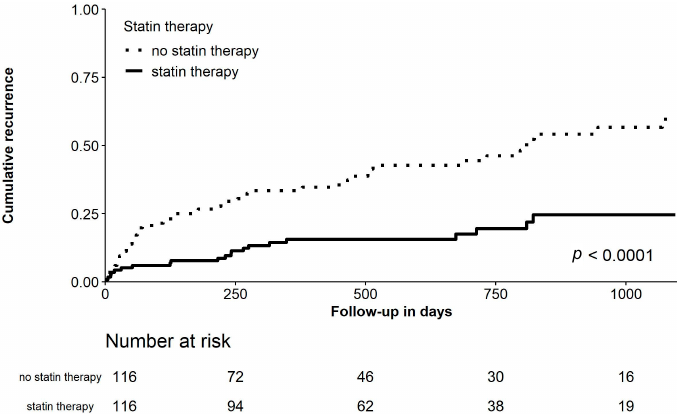
Figure 1. Cumulative incidence curve for recurrence of atrial fibrillation after CV comparing all patients with and without statins, with the log-rank test.